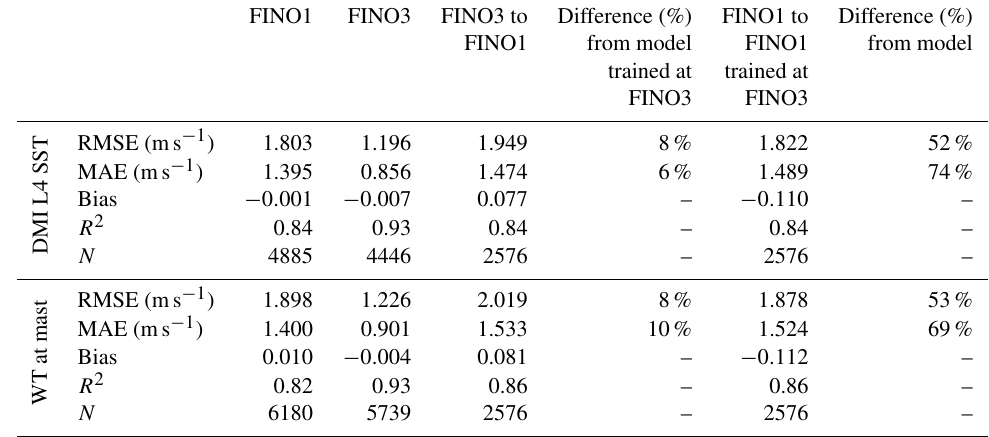
Table 6. Round-robin model evaluation from FINO3 and FINO1 using the DMI L4 SST product and water temperature (WT) measurements at each